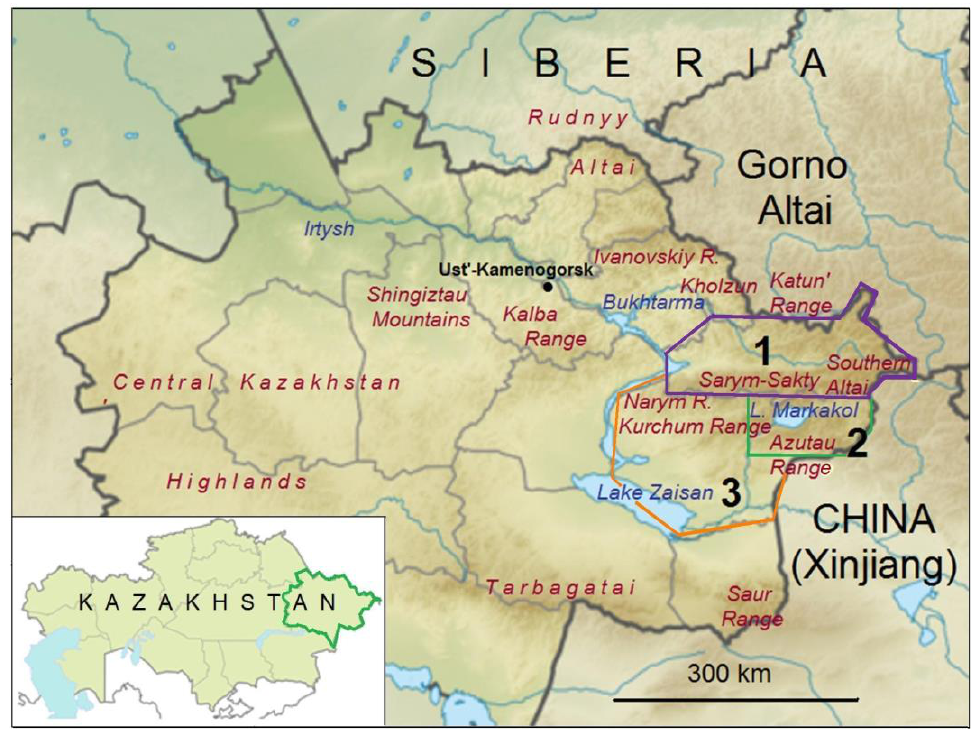
Figure 1. Geographical location of the investigated area, East Kazakhstan Region, with the main tourism and nature recreation districts: 1-Katon Karagay NP, 2-Lake Markakol, 3-Kurchum. The Kazakh Altai and the adjoining rural regions have been largely untouched by mass tourism of any form comparing to the Russian Gorno Altai in spite of a geographic unity and proximity of both regions [11,24,25]. About 3000–4000 people only visit the most attractive places of Lake Markakol and the Kaldzhyr River area during the summer season [26]. In the mid-2000s, merely a few dozens of foreign tourists visited the Katon-Karagay National Park, being the major state-protected territory in Kazakhstan [27]. The expansion of the local tourism is bound to the supreme places (geosites) combined with the traditional rural economy highlights and interesting domestic facilities such as red-deer and horse-breeding farms, home spas ( banyas ) and yurts—among